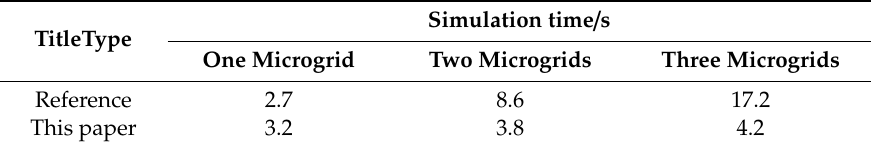
Table 6. Comparative analysis with other literature.